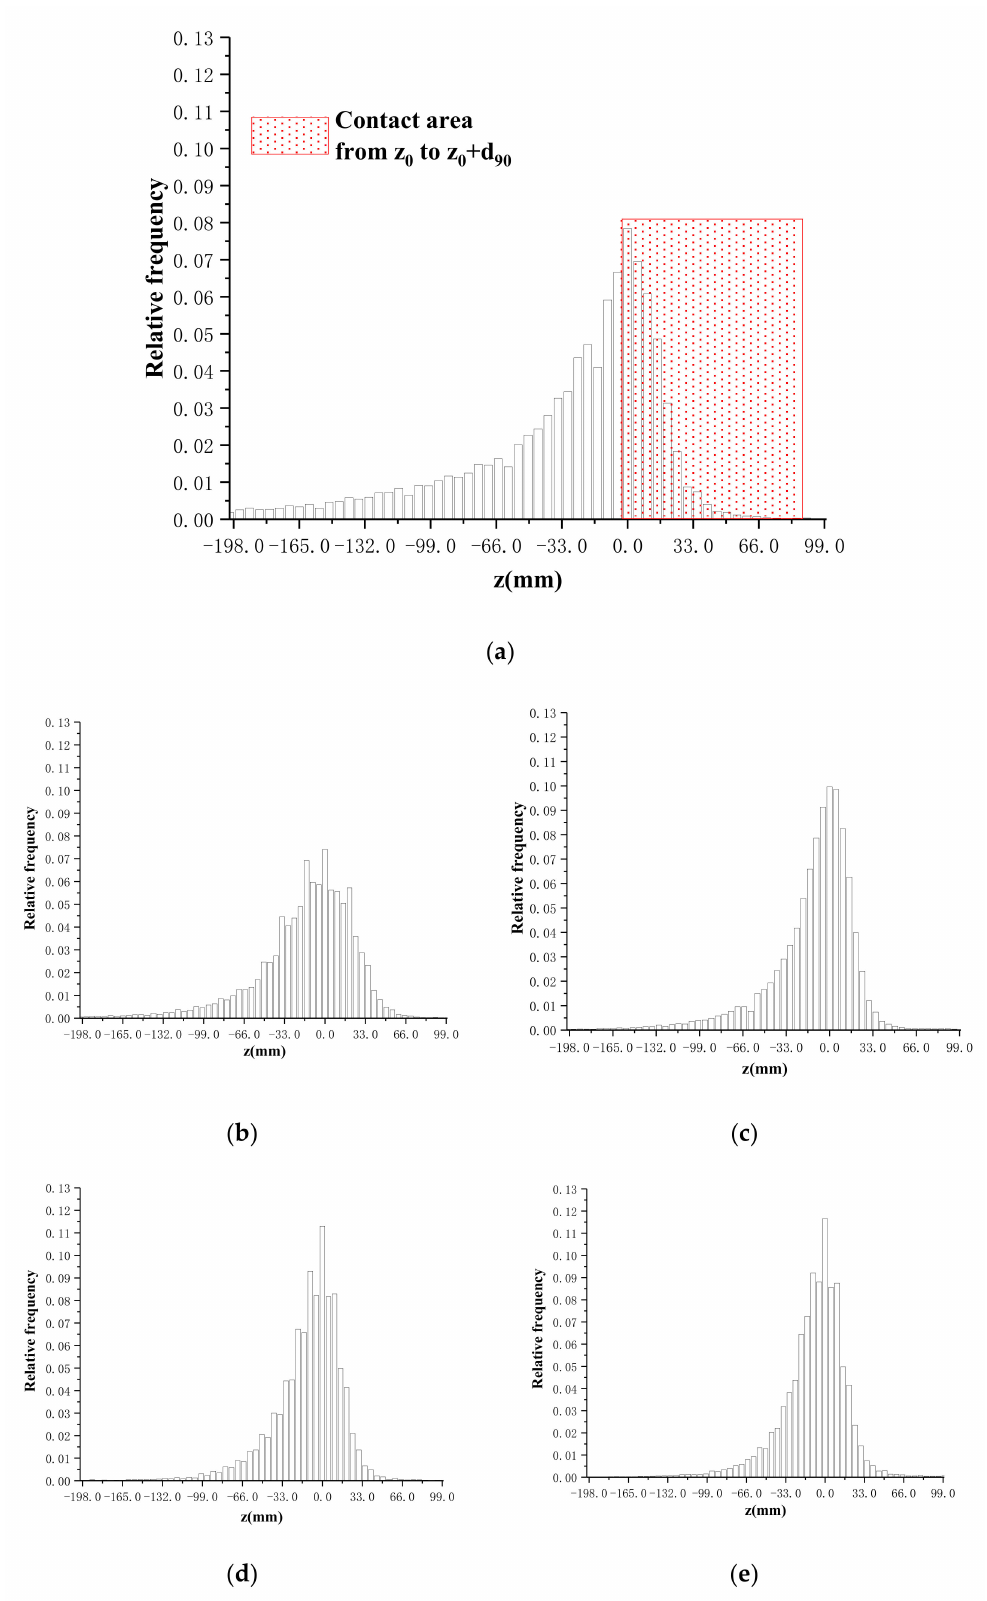
Figure 11. Frequency histogram corresponding to various height in the Z direction. ( a ) 106 MPa; ( b ) 211 MPa; ( c ) 317 MPa; ( d ) 423 MPa; ( e ) 529